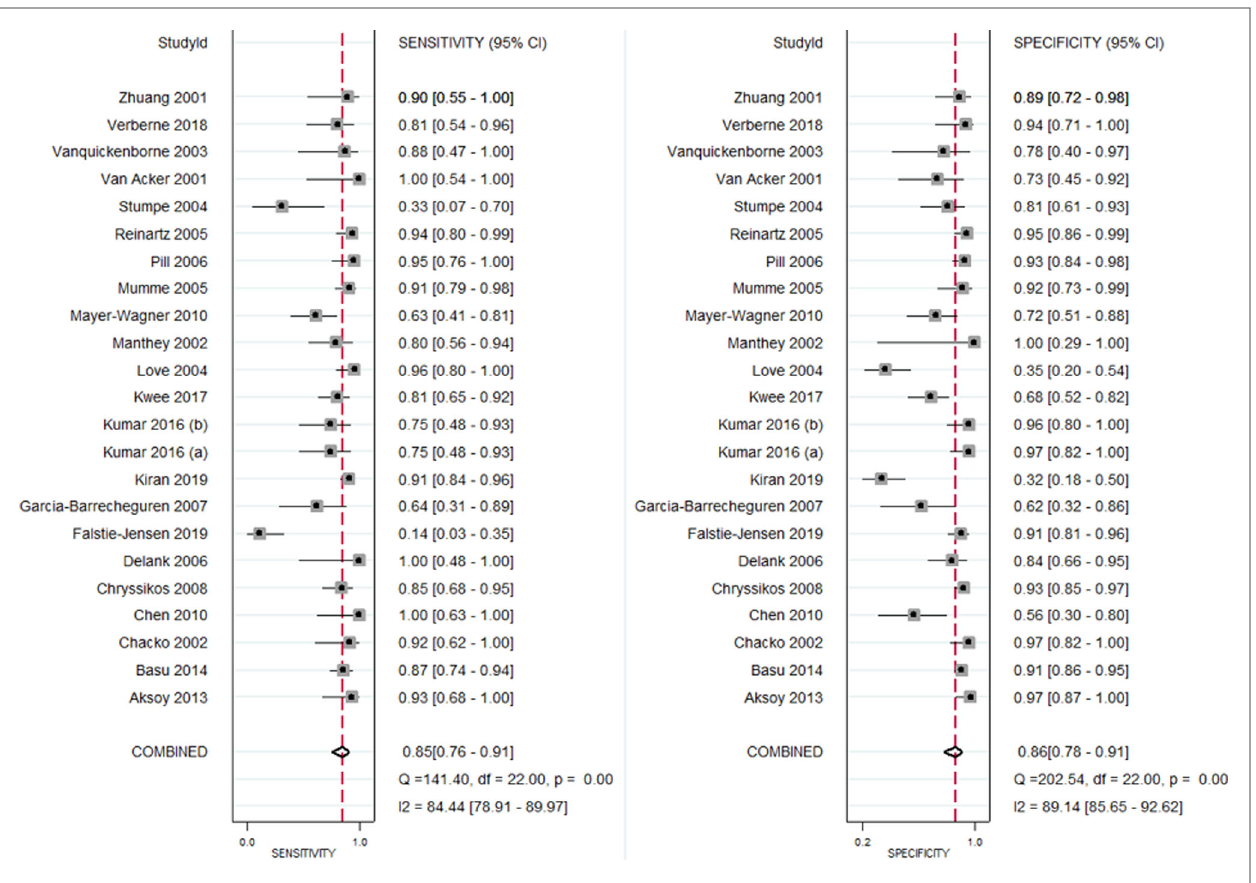
FIGURE 3 | Forest plot showing pooled sensitivity and speci fi city for